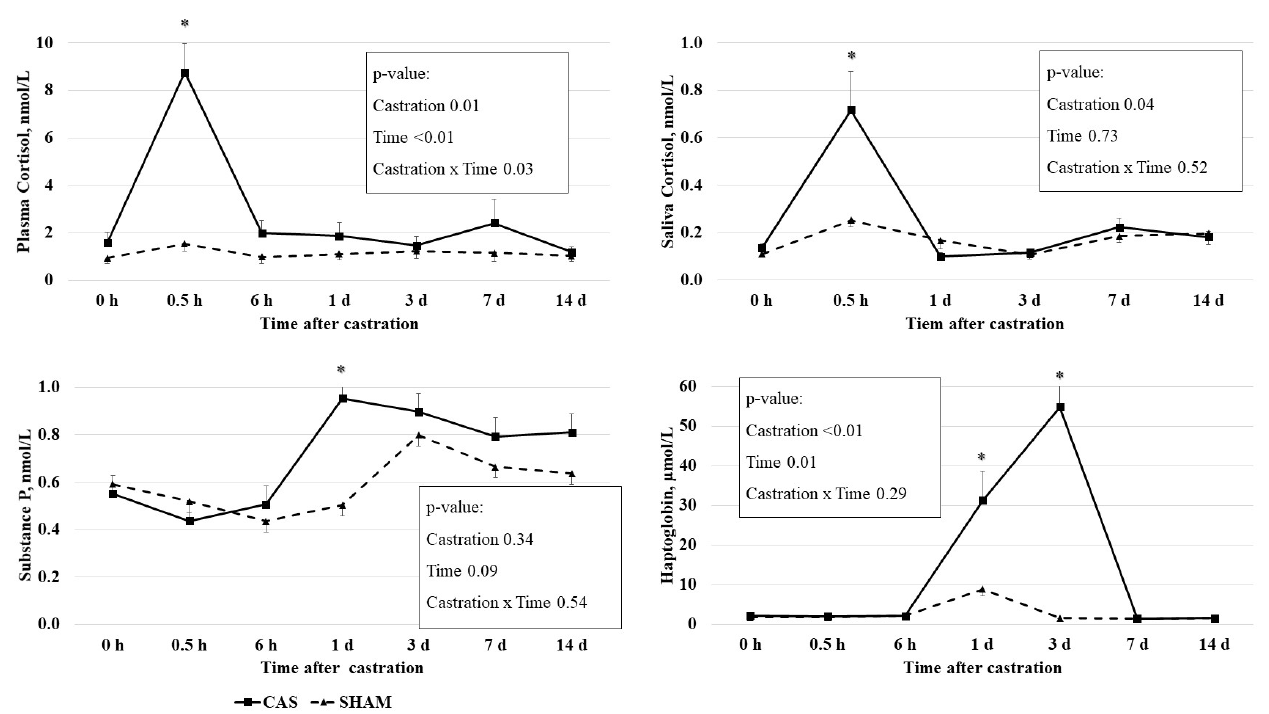
Figure 1. Effect of castration on plasma concentrations of cortisol, substance P, and haptoglobin and saliva cortisol concentrations in Korean cat- tle calves. Male calves were allocated into two groups: CAS = castration (n = 10); SHAM = sham (n = 9). Values represent the mean+standard er- ror of the mean. The p-values indicate results of two-way repeated measures analysis of variance analysis. An asterisk (*) indicates that the val- ues differ between castration and sham group at each time point (p<0.05, t-test).